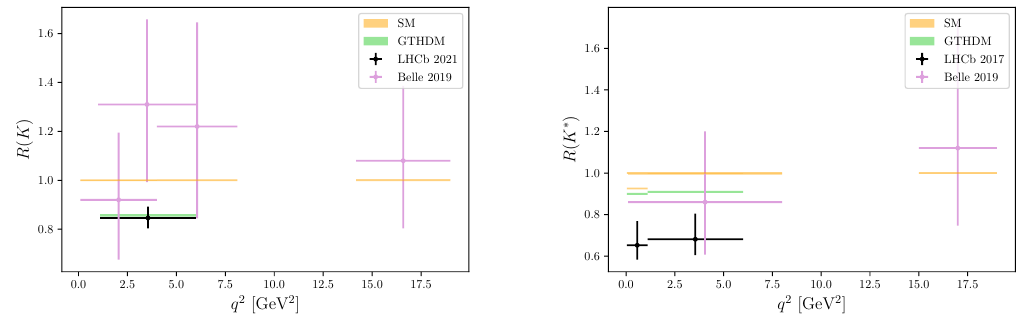
Figure 14 . R ( K ( ∗ ) ) theoretical ratios compared to both the LHCb [150, 152] and Belle data [197, 198].